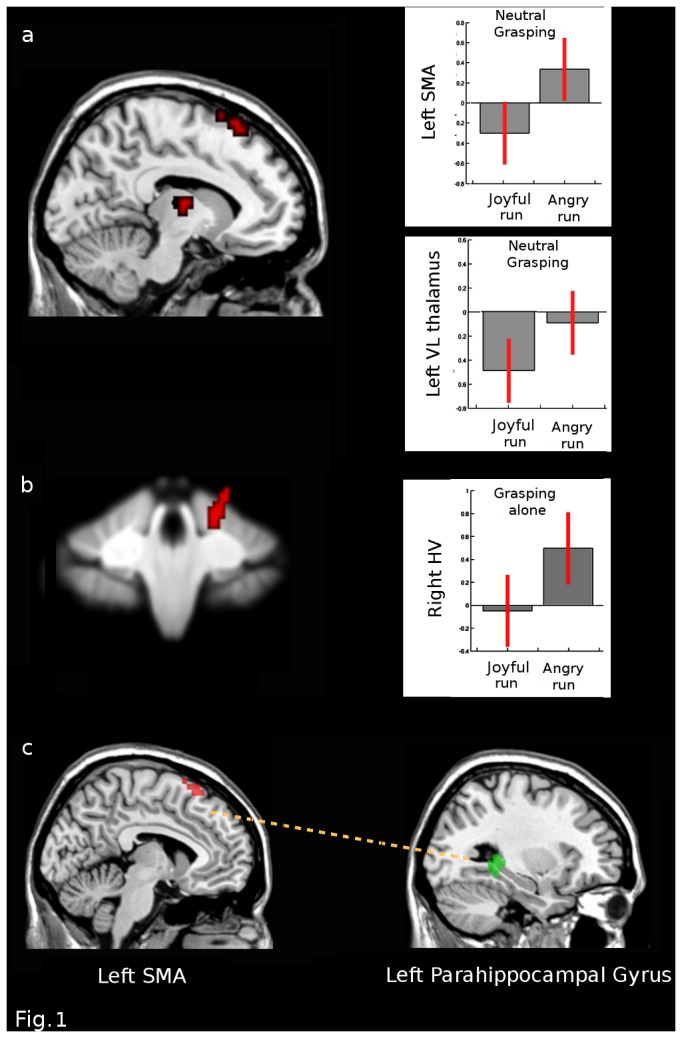
Interaction and PPI analyses between Grasping and Neutral Grasping across emotional contexts.BOLD response in terms of % signal change in the two emotional contexts: fMRI result for the 2-way interaction analyses in: a) the left SMA (peak coordinates x= -7, y= 27, z= 65, P<0.05 FWE corrected); the left VL thalamus (peak coordinates x= -14, y= -11, z= 10, P<0.05 FWE corrected). b) the right cerebellar lobule HV (peak coordinates x= 18, y= -38, z= -21, P<0.05 FWE corrected) (Mean±0.95 confidence intervals). c) PPI analysis: seed region in the left SMA (peak coordinates x= -7, y= 27, z= 65, P<0.05 FWE corrected); left parahippocampal gyrus/BA19 (peak coordinates x= -33, y= -41, z= -5, P<0.05 FWE corrected). Bars depict variance loadings and 90% confidence intervals.